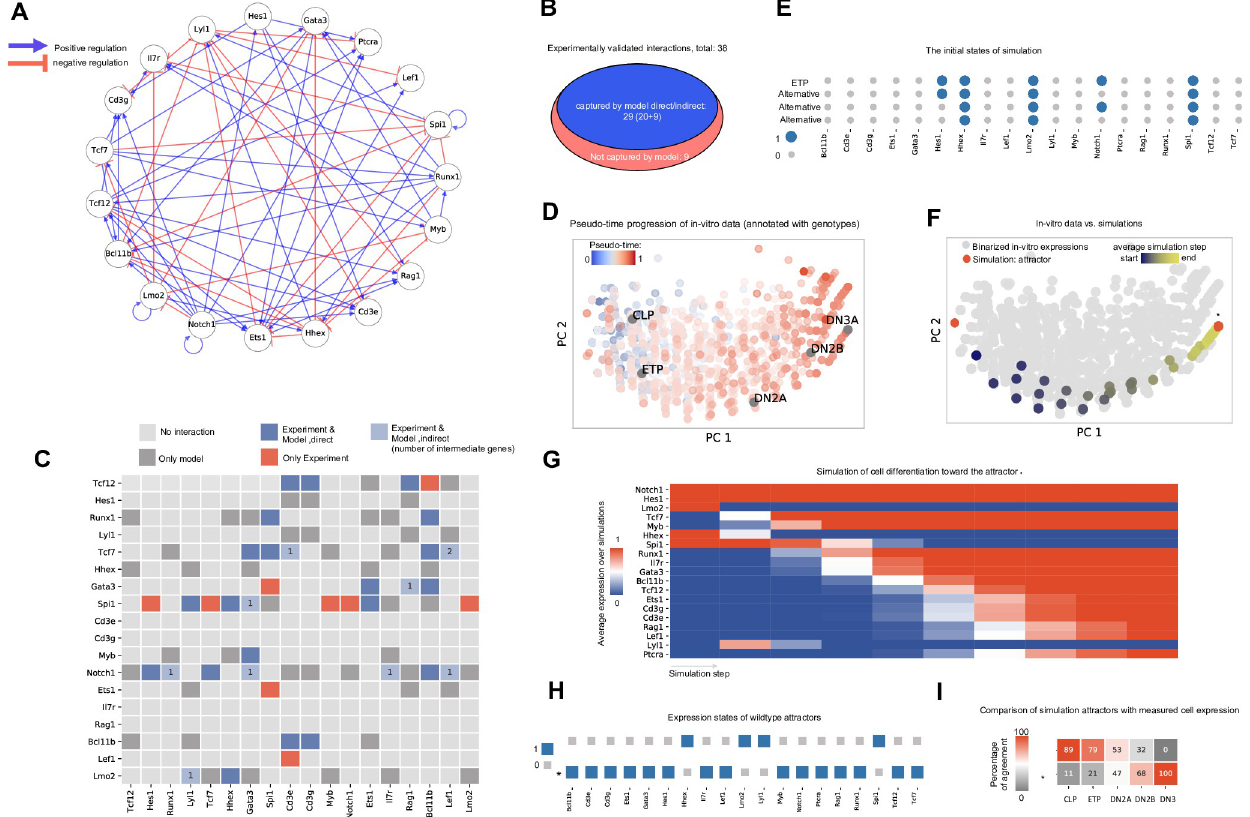
Fig 3. The provisional GRN for mouse early T-cell development inferred by IQCELL captures essential gene interactions and accurately simulates T- cell developmental trajectories. (A) The provisional GRN for early mouse T-cell development. The GRN is obtained by constraining the possible interactions to both follow the in vitro data progression when executed as a logical network and maximize mutual information between gene pairs. Positive and negative interactions are represented by blue and red edges, respectively. (B) Out of 38 experimentally reported gene interactions of early mouse T-cell development [16], 29 of them are captured by the functional GRN model proposed by IQCELL. (C) Detailed representation of the proposed interactions by IQCELL and experimentally reported ones. Rows and columns represent regulators and effector genes, respectively. Blue indicates that the interaction is captured by the model directly (dark blue) or indirectly (light blue); in the latter case, the numbers indicate the number of intermediate genes. Dark gray indicates that the interaction is only proposed by IQCELL. The red color indicates the experimentally validated interaction is not present in the model. Light gray cells indicate no interaction. Genes downstream of Spi1 comprise 50% of the experimentally-reported interactions not captured by IQCELL. (D) The PCA plot of the binarized scRNA-seq data color-coded with the pseudo-time values attributed to each cell. The binarization is performed by clustering the scRNA-seq expressions into expressed or not expressed levels. On top of that, the binarized expressions of CLP, ETP, DN2A, DN2B, and DN3A cells have been calculated from the Immgen microarray data [38] and overlaid on RNA-seq data. (E) The four initial states that have been used in simulations. Three variations of the state representing ETP are due to the noisy expressions of Notch1 and Hes1 genes in recovered sc-RNA seq data with early pseudo-time. Genes that are expressed (1) and not expressed (0) are represented with blue and grey circles, respectively. (F) The PCA plot of the simulated developmental trajectories are overlaid on the binarized scRNA-seq. The two detected attractors are colored red, and the attractor that matches the DN3A state is marked by star ( � ). The simulated data is color coded by the value of average simulation step (average distance to the attractor of simulation). (G) Average gene expression at each simulation step. All simulations started from the same initial condition (ETP) and move toward the same attractor ( � ). (H) Expression states of the GRN model steady state attractors. Genes that are expressed (1) and not expressed (0) are represented with blue and grey squares, respectively. (I) Percentage of similarity between the two attractors (vertical axis) and binarized microarray expression profiles of CLP, ETP, DN2A, DN2B, and DN3A cells (horizontal axis) [38]. The average agreement between two random states is 50%. interest, of which 29 (over 75%) are de novo captured directly by our simulated functional reg- ulatory network ( Fig 3B and 3C ). For example, it is well known that Bcl11b , the gene that marks T lineage commitment, is activated by Notch signaling, Gata3 , Tcf7 , and Runx1 [34]. Our model predicted four activators for Bcl11b : Notch1 (as a Notch signaling mediator [35] and target gene [36] functionally represents the presence of Notch signaling), Gata3 , Tcf7 , and Runx1 . The presence of Runx1 in our model is a notable result. Runx1 is present in developing